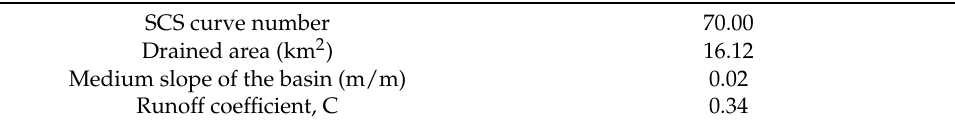
Figure 4. Trace of the Thiessen polygons to estimate the average rain, which includes the location of weather stations. Table 1. "La Yerbabuena" micro-basin hydrogeological